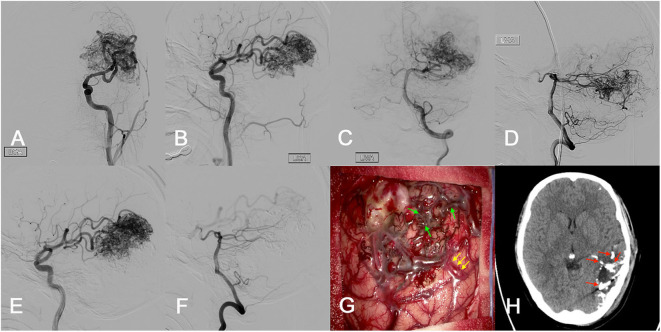
Illustration case. A 25-year-old female presented with loss of consciousness accompanied by physical convulsions 10 days before admission. (A–D) The preoperative imaging examination suggested an unruptured AVM in the left parietal occipital lobe (SM grade IV). The maximum diameter was 7.1 cm. The nidus was supplied by the ipsilateral middle cerebral artery (MCA) and posterior cerebral artery (PCA). The nidus was compact. She received a single-stage combined embolization and resection 4 days after admission. (E,F) The intraoperative embolization was mainly performed on the nidus supplied by the ipsilateral PCA, and the overall embolization degree was Grade B (30–60%). (G) After craniotomy, the main feeding artery was controlled and blocked with aneurysm clips (main feeding artery: yellow arrow). The embolized vessels and lesions appear black (embolized lesions: green arrow), which make the lesion boundary easy to be identified. (H) Intraoperative DSA and postoperative CT showed completely obliteration of the lesion. In order to preserve important neurological functions, a small number of embolized lesions adjacent to the eloquent area were maintained during resection (maintained embolized lesion: red arrow). Immediate DSA after the microsurgical resection procedure demonstrated complete obliteration of the lesion. The intraoperative blood loss was 200 ml and the resection duration was 2.9 h. After 2.4 years' follow-up, she experienced no neurofunctional deficit and mRS score of 0.